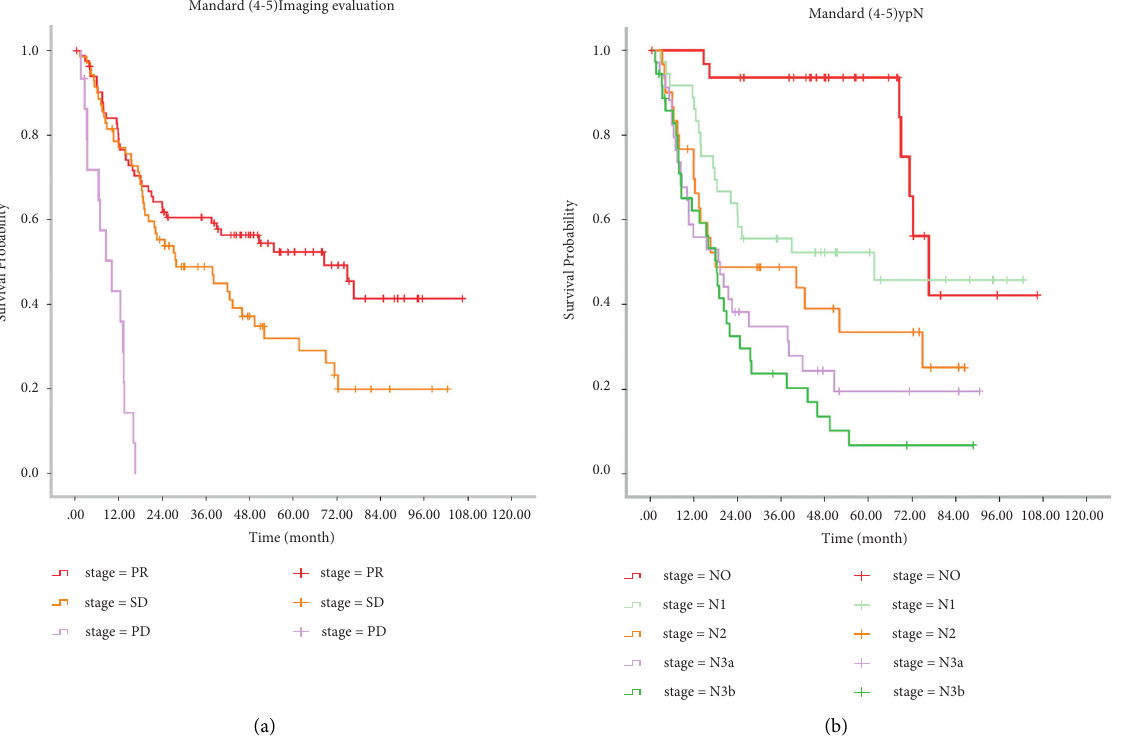
Figure 3: Kaplan–Meier survival analysis for the Mandard score (4-5) group. (a) By the imaging evaluation group. (b) By the ypN